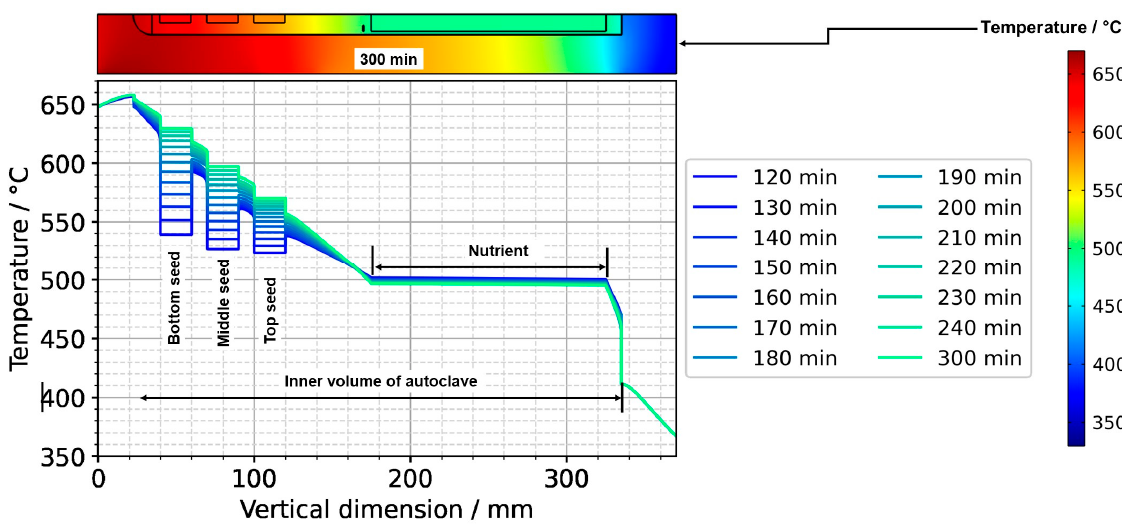
Figure 12. Temperature distribution in vertical direction in the center (120 min: reaching of growth stage set temperatures, 300 min quasi-stable conditions of growth stage).